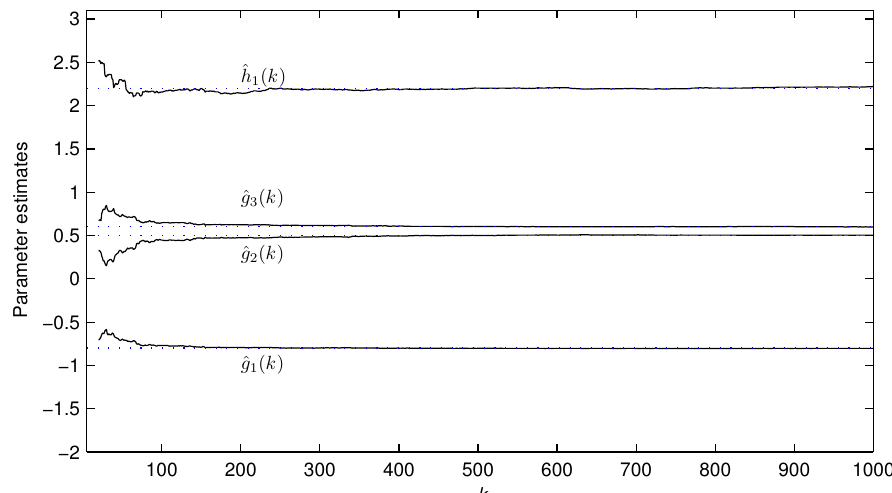
Figure 7. The parameter estimates ˆ g 1 ( k ) , ˆ g 2 ( k ) , ˆ g 3 ( k ) and ˆ h 1 ( k ) versus k for Example 2.